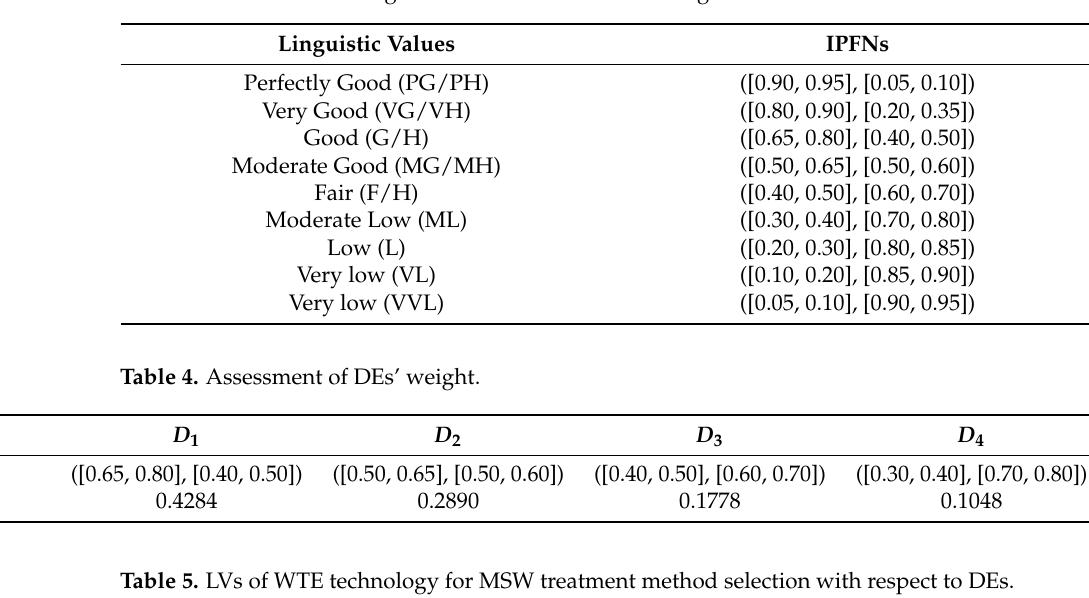
Table 3. Performance ratings of alternatives in terms of linguistic values.